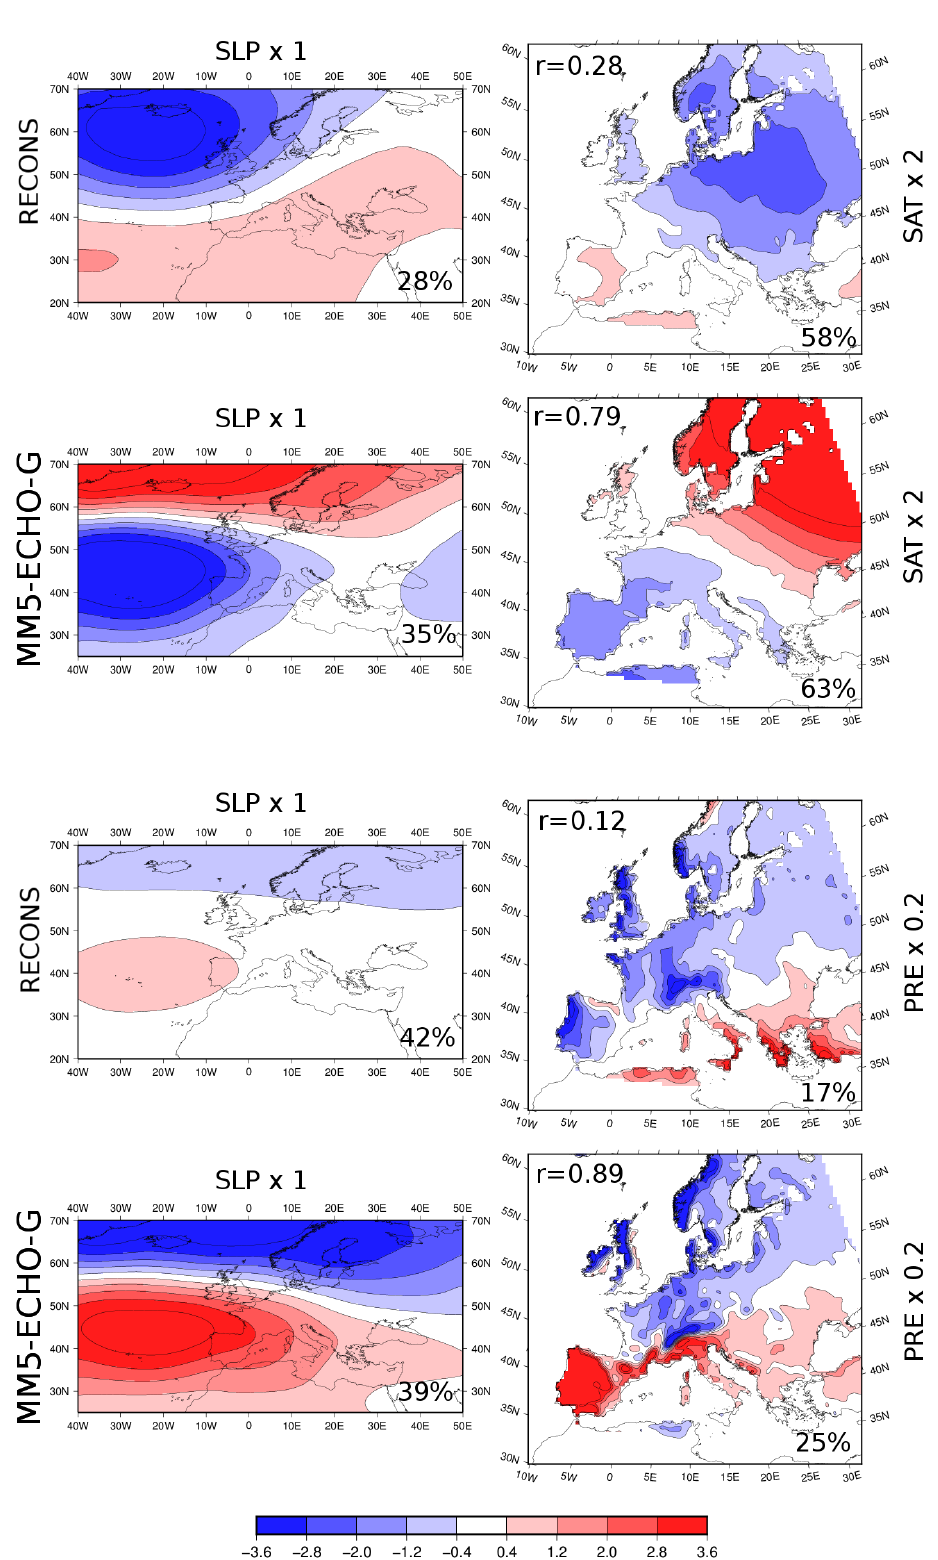
Figure 11. As in Fig. 10 but for the simulation and reconstructions. The calculations are based on the overlap period of the simulation and the SLP reconstructions,